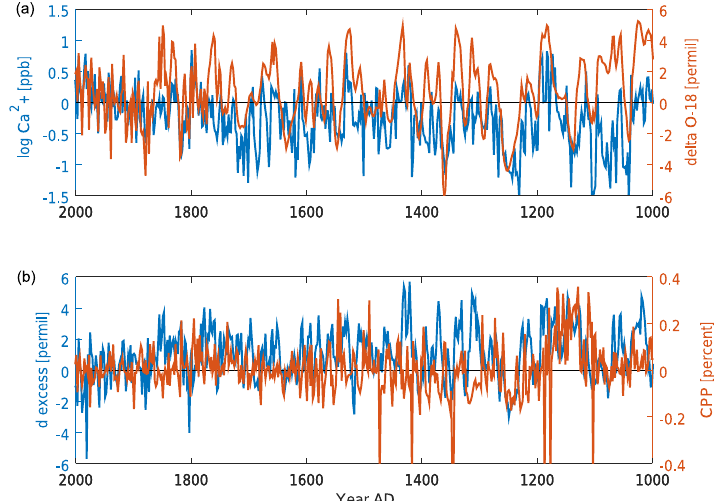
Figure 7. Records of KCC, displaying δ 18 O together with Ca 2 + (a) and deuterium excess together with the coarse particle percentage (CPP, b ), shown in blue and orange, respectively. All time series are shown as anomalies relative to the respective AD2000–1860 mean at biennial resolution. Note the high levels of deuterium excess and CPP around